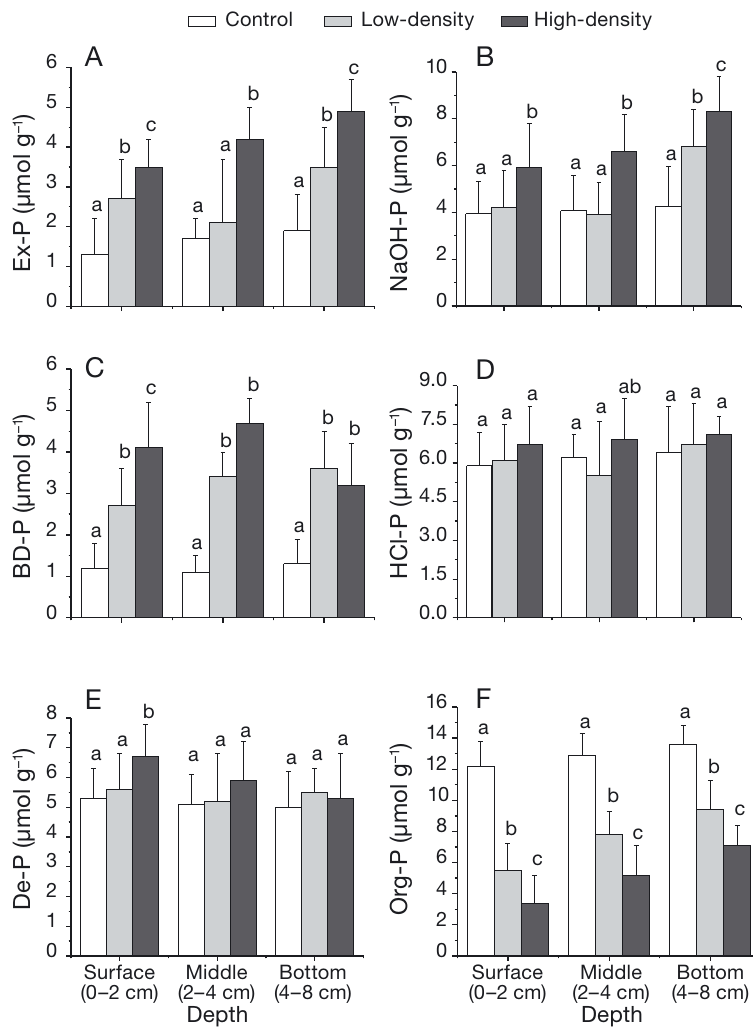
Fig. 2. Phosphorus (P) concentrations (mean ± SD; n = 4) of the vertical distri- butions of different P fractions: (A) exchangeable or loosely sorbed P (Ex-P), (B) metal oxide-bound P (NaOH-P), (C) redox-sensitive P (BD-P), (D) calcium- bound P (HCl-P), (E) detrital P (De-P), and (F) organic P (Org-P), measured in